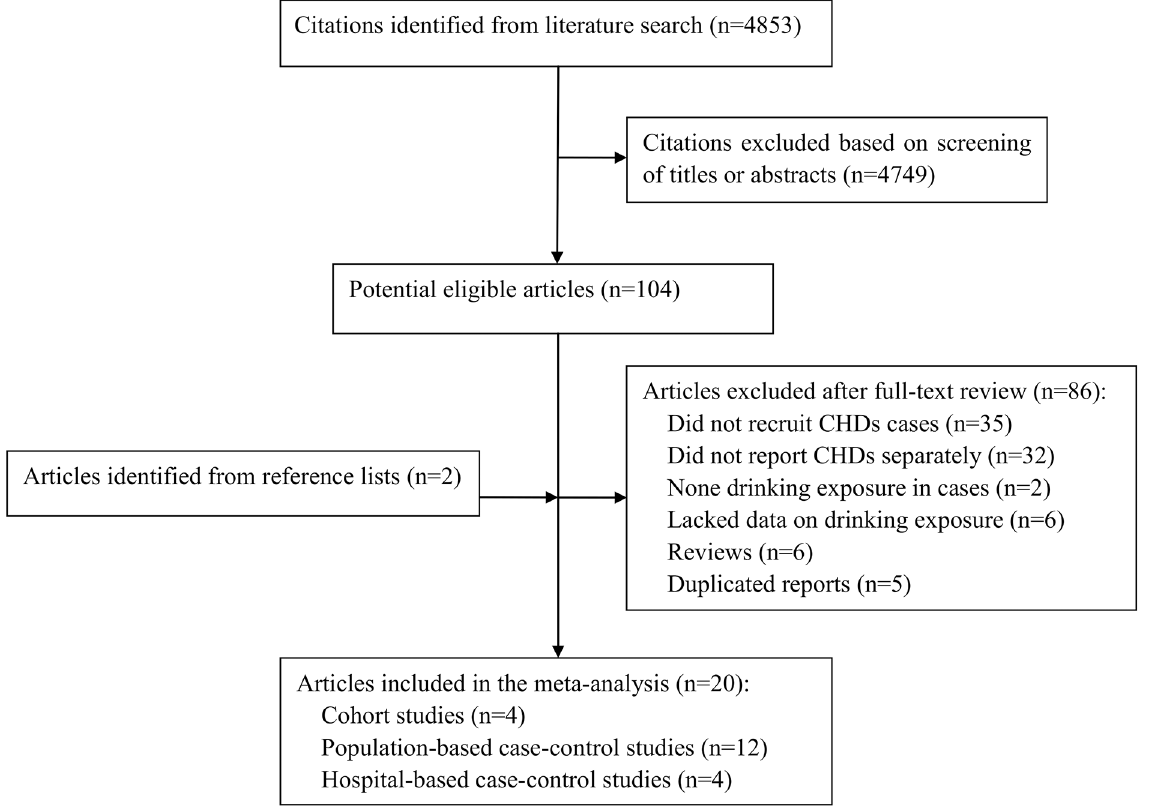
Fig 1. Flow chart of screening for literature about prenatal alcohol exposure and congenital heart